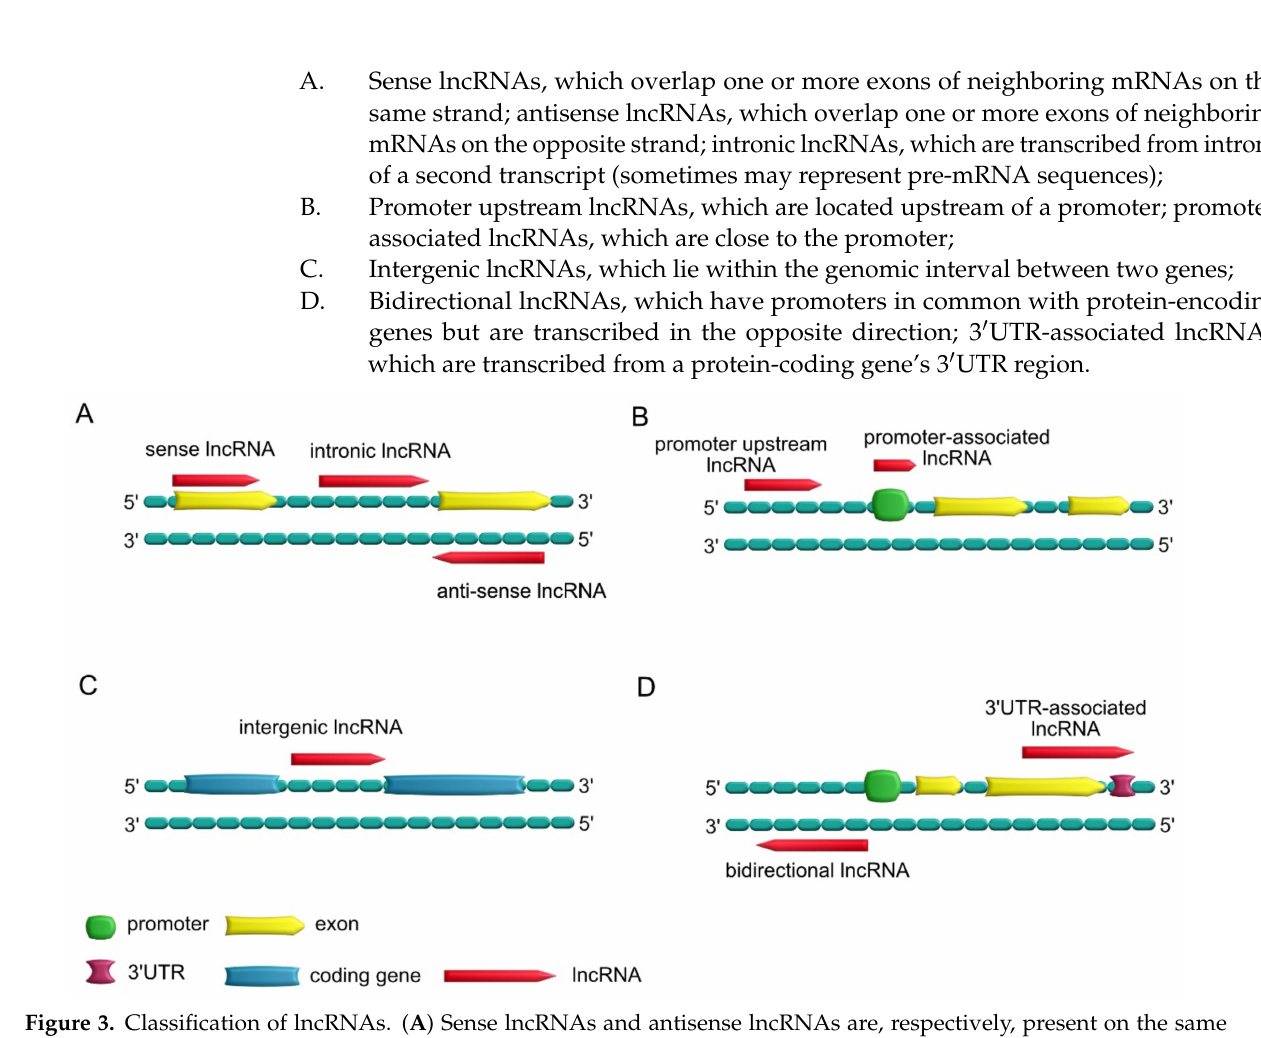
Figure 3. Classification of lncRNAs. ( A ) Sense lncRNAs and antisense lncRNAs are, respectively, present on the same and opposite strands and overlap with neighboring mRNAs; intronic lncRNAs are transcribed from the introns of the protein-coding genes. ( B ) Promoter upstream lncRNAs are located upstream of the promoter; promoter-associated lncRNAs are close to the promoter. ( C ) Intergenic lncRNAs are transcribed from the genomic interval between two genes. ( D ) Bidirectional lncRNAs have transcription start sites that are close to adjacent genes on the antisense strand, and these have common promoters; 3 (cid:48) UTR-associated lncRNAs are obtained from a protein-coding gene’s 3 (cid:48) UTR